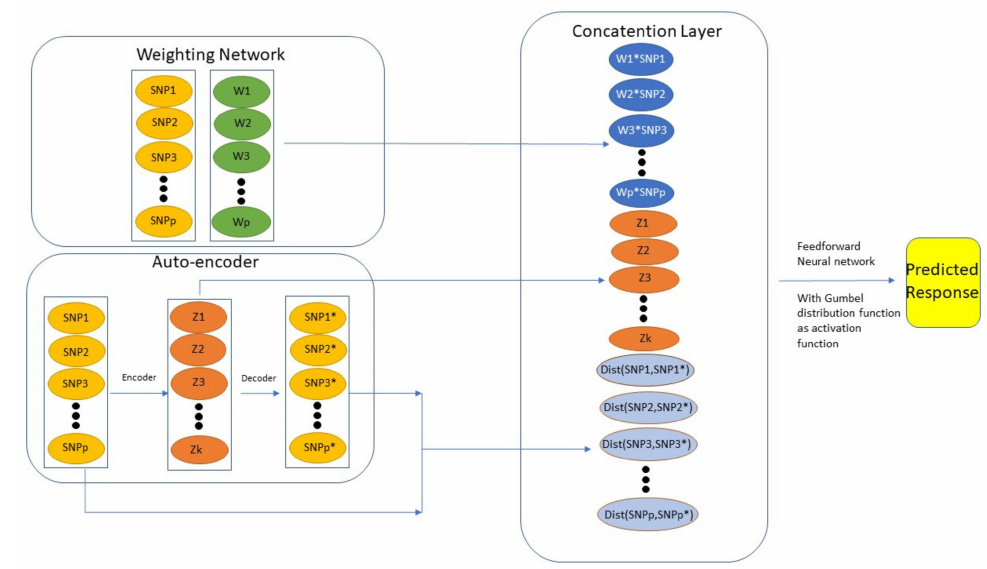
Figure 1. Overview of GEV-NN